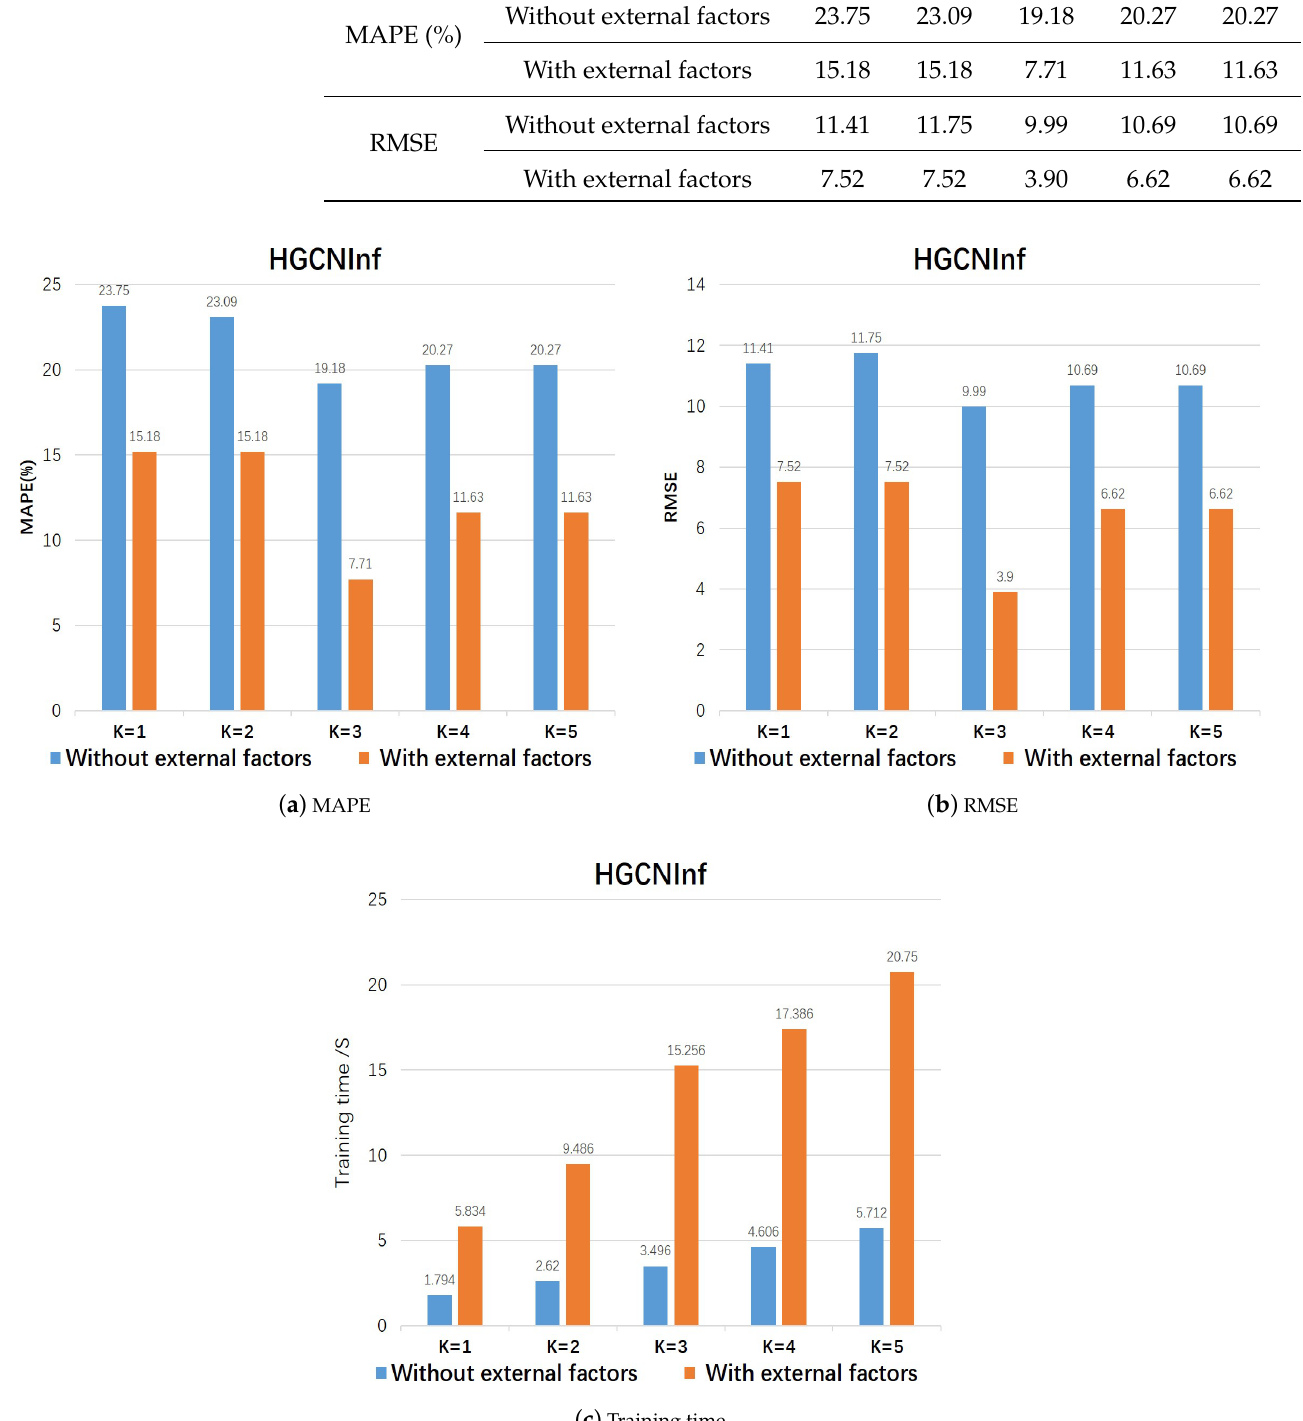
Figure 10. The HGCNInf training efficiency of different